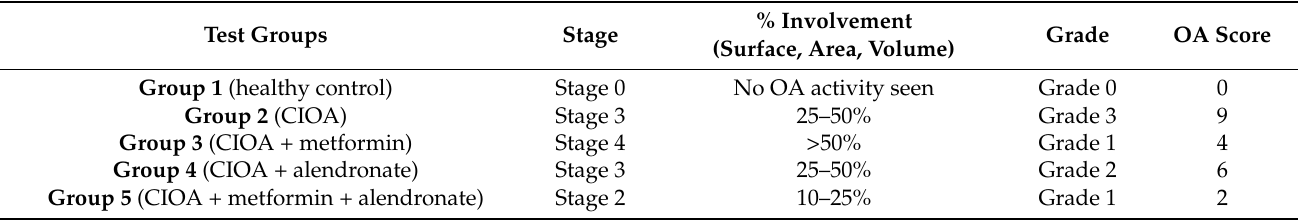
Table 2. Stage * of the histopathological alterations and OA score (OA score = grade × stage) according to Pritzker et al. (2006).